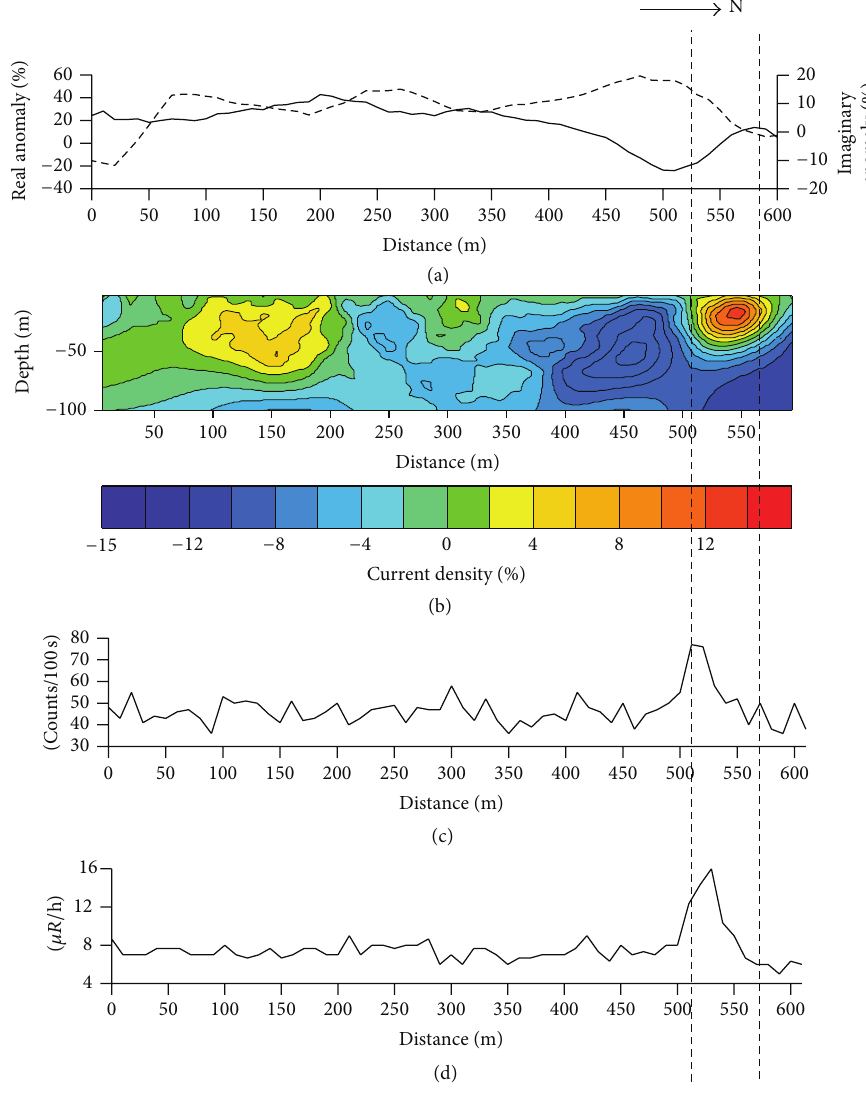
Figure 3: Profile P1200: (a) VLF anomaly (real by solid line and imaginary by dashed line), (b) pseudo current density cross-section along profile P1100, and (c) surface radiation and (d) surface gamma